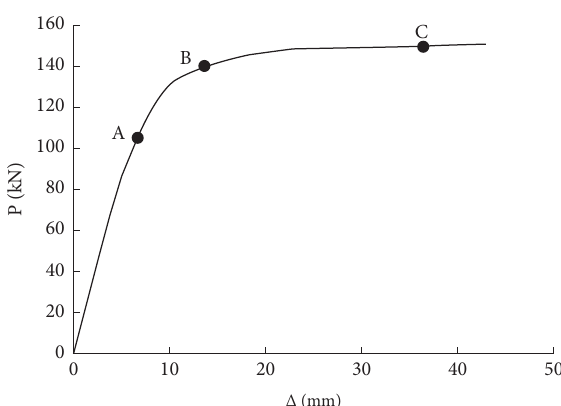
Figure 9: Load and deflection curve of damaged steel beam strengthened with CFRP sheet.